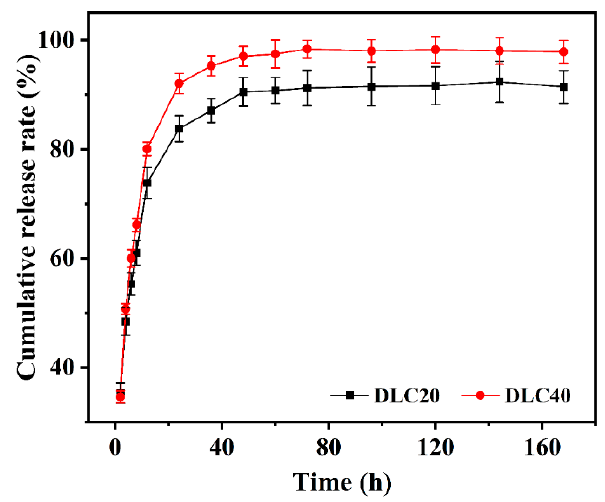
Figure 7. Cumulative drug release curve of drug-containing hydrogels.